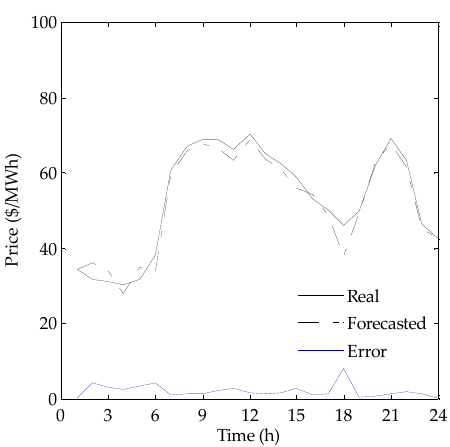
Figure 9. April, 07th 2006 results for the PJM (Pennsylvania ‐ New Jersey ‐ Mary) market.